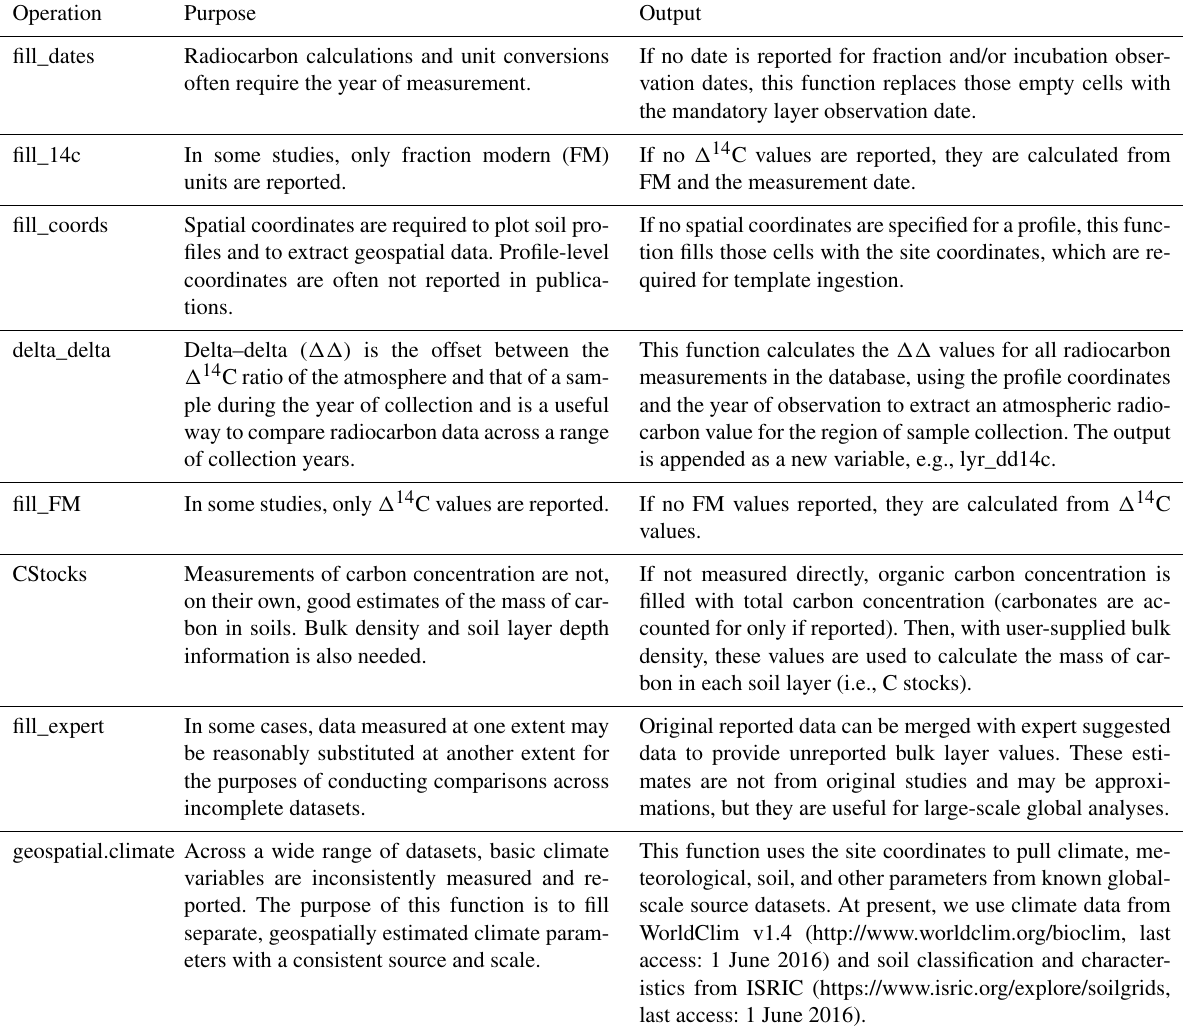
Table 2. Details of some core calculations included with ISRaD_extra. Additional variables will be regularly added to ISRaD_extra, and an up-to-date list can be found at http://soilradiocarbon.org (last access: 16 December 2019).